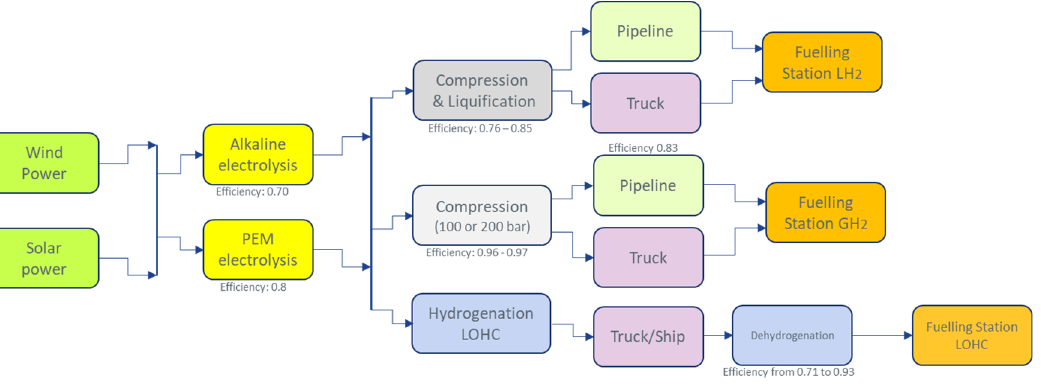
Figure 6. Pathways for green hydrogen production, transport, and consumption by fueling sta- tions.